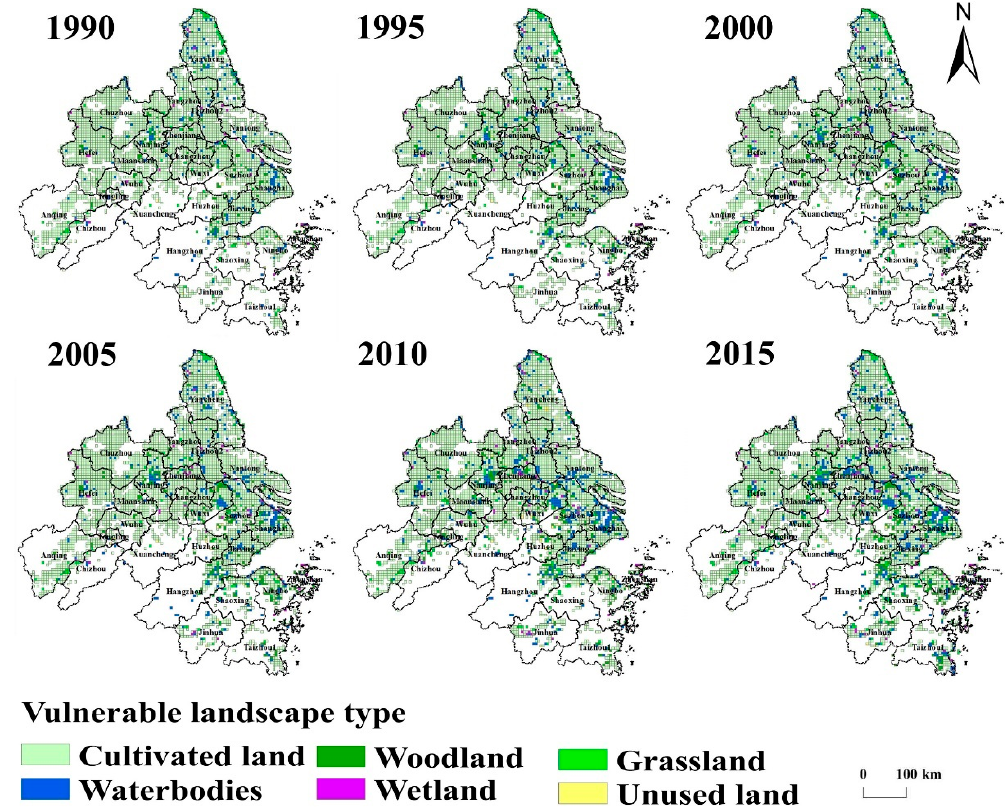
Figure 4. The spatial variation in the vulnerable landscape in the YRD from 1990 to 2015 ( V i ≥ 0.6 for all classes of natural landscape). The white grid cells indicate there was no common edge between the urban landscape and corresponding natural landscape.